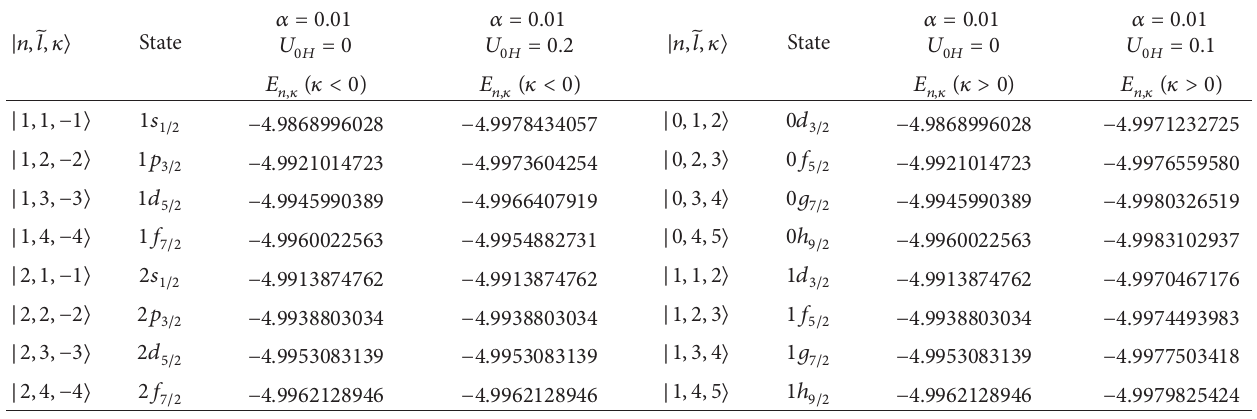
Table 4: The bound state energy eigenvalues in unit of fm −1 of the p-spin symmetry Hulth´en potential. Here the first states column according to (𝑙,𝑗) and second states column (𝑙 + 2,𝑗 + 1) .